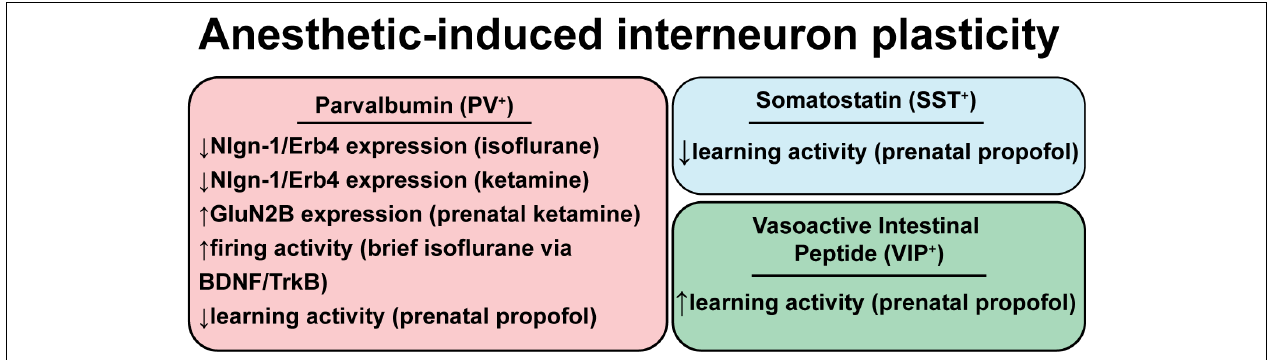
FIGURE 3 | Anesthetic-induced interneuron plasticity. Review of evidence for persistent changes in interneuron function following anesthetic exposure. Abbreviations: Nlgn1/Erb4, signaling between neuroligin-1 and its receptor ErbB4; GluN2b, N-methyl D-aspartate receptor subunit 2B; BDNF, brain-derived neurotrophic factor; TrkB, tropomyosin receptor kinase